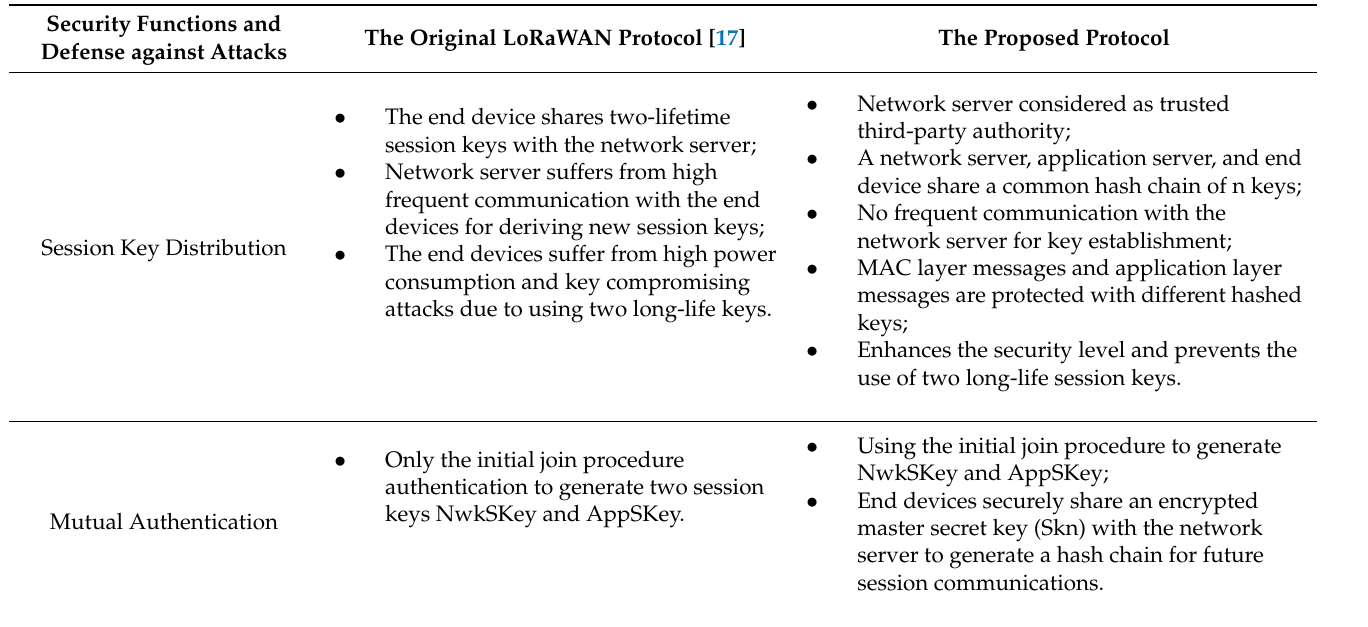
Table 3. The security comparison of the proposed key management protocol with the original LoRaWAN. Security Functions